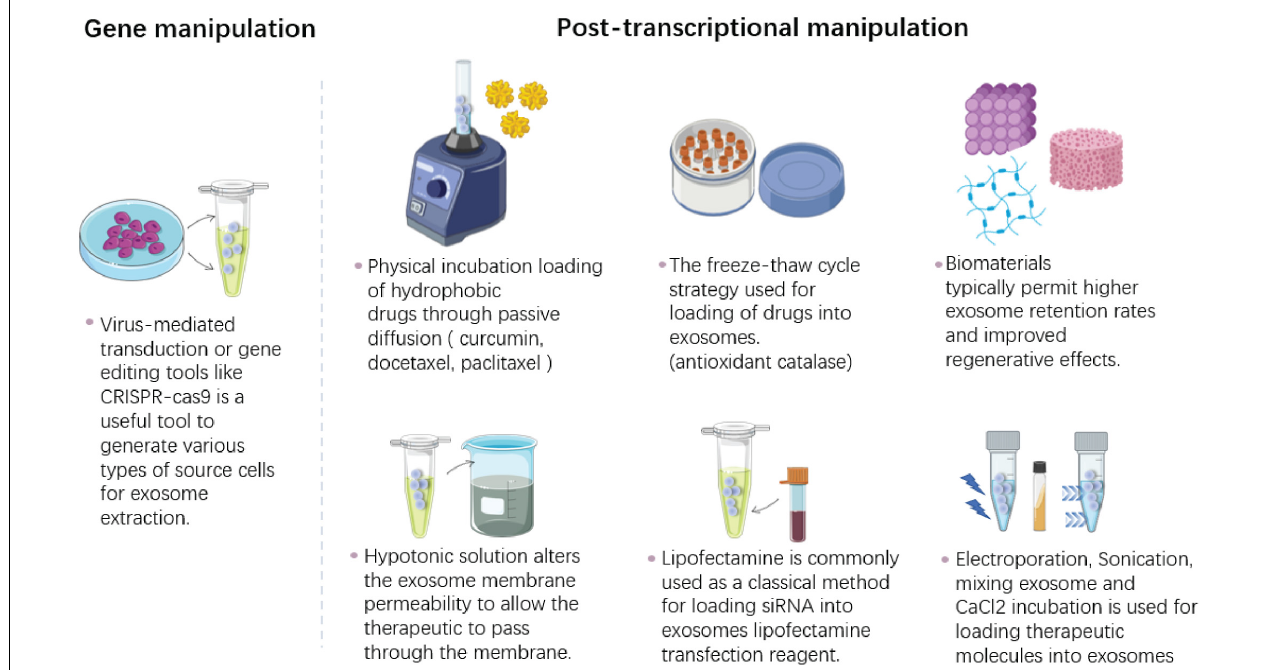
FIGURE 5 | The bioengineering modification of exosomes. This is a simplified illustration of methods for modification of therapeutics into exosomes. The methods are basically divided into two parts, the gene manipulation modification and the post-translational modification. The first one is to use virus mediated system or gene editing techniques to modify the parental cells before exosome extraction. The other way is to directly modify exosomes after the isolation process by various method including incubation, electroporation, sonication, extrusion, hypotonic dialysis, freeze-thaw cycles, saponin, CaCl 2 and lipofectamine